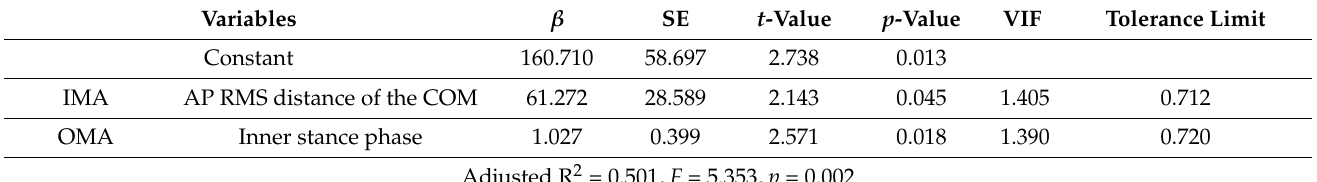
Table 4. Association between NFOGQ scores and turning characteristics for freezers during the 180 ◦ turning